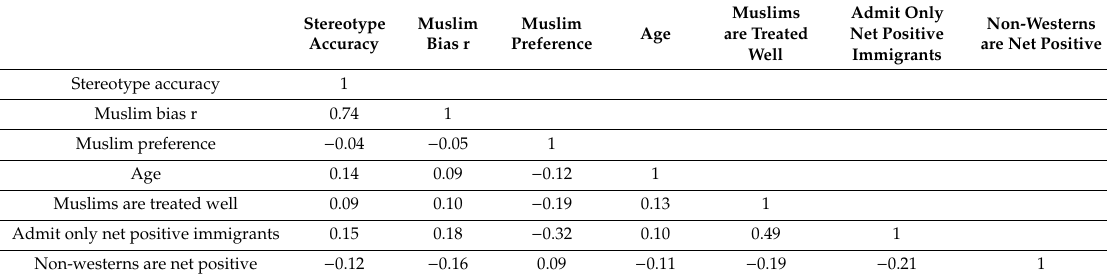
Table 5. Correlation matrix between the primary individual-level variables and